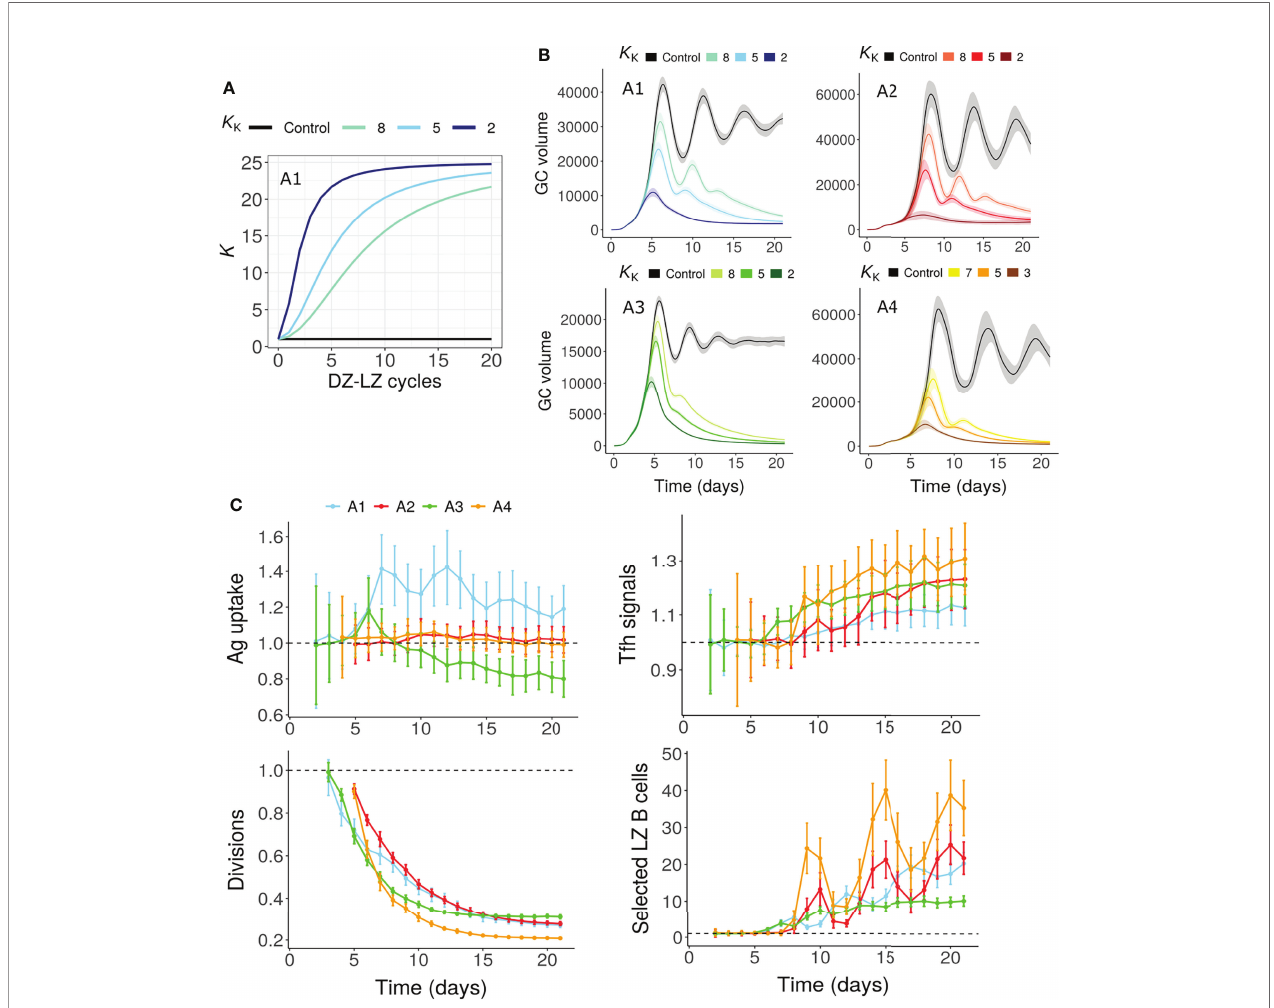
FIGURE 5 | GC shutdown due to limited B cell division capacity (Mechanism 7). (A, B) K vs number of DZ-LZ cycles according to Equation 11 (A) and GC dynamics (B) for assumptions A1-A4. Colors represent different values of K K as shown above the panels and black curves represent the control simulation. K K controls the increase in K with increasing number of DZ-LZ cycles. The value of K determines the dependence of the number of divisions on the amount of antigen captured in assumptions A1/A2 or Tfh signals acquired by B cells in A3/A4 (see Methods). Solid lines and shaded regions represent mean and standard deviation of 50 simulations, respectively. (C) Average antigen uptake per B cell, Tfh signals acquired per B cell, average number of divisions per recycling GC B cell and fraction of Tfh selected LZ B cells (with K K = 5). Readouts were normalized with that of the control simulation. Colors represent the assumptions A1-A4. Error bars represent standard deviation of 50 simulations. GC, Germinal center; Tfh, T follicular helper cell; Ag, Antigen; DZ, Dark zone; LZ, Light